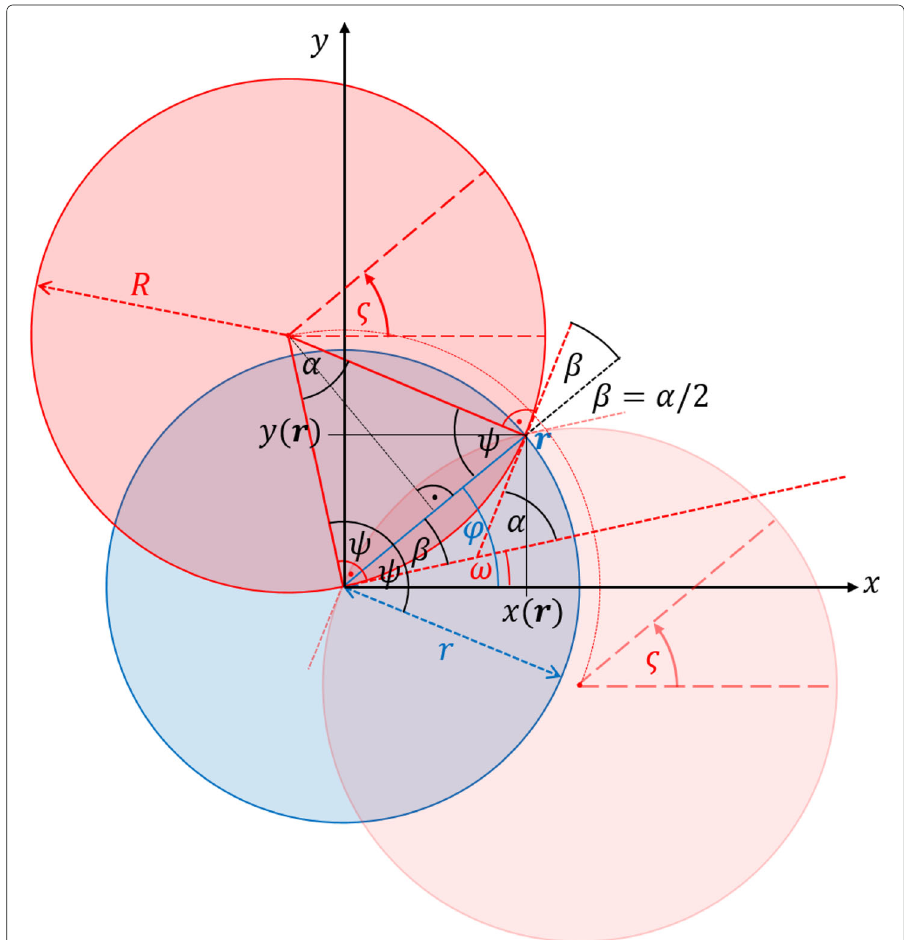
background density 4 , i.e. π r 2 ρ , plus ii ) the line length of the intersection with the circular disc of the dislocation the point is located on. The latter is the length of the intersection of a circle of radius R through the origin with the circular disc of radius r , as depicted in Fig. 1. The angle corresponding to the intersecting red circle segment is twice the angle α shown in Fig. 1. As may be read from the red-blue triangle in Fig. 1, this angle is given as a function of r (and R , which we assume fixed) by r α( r ) = 2 arcsin . (52) 2 R The expected line length in a circle of radius r around a typical point on a loop contains two segments with angular range α( r ) , such that the average line length in a circle of radius r around a point on a dislocation reads r L ( r ) = π r 2 ρ + 4 R arcsin . 2 R